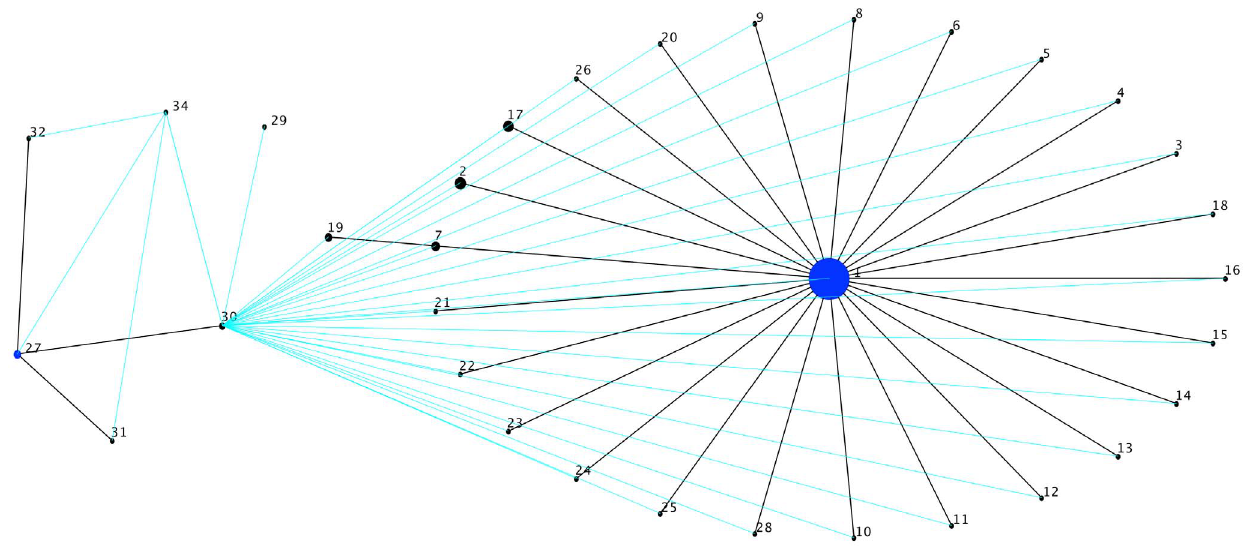
Figure 2. Genotype network of the Yersiniapestis strains. Main clonal complex composed of 26 genotypes and encompassing 135 isolates; Secondary clonal complex composed of six genotypes and distributed among nine isolates.